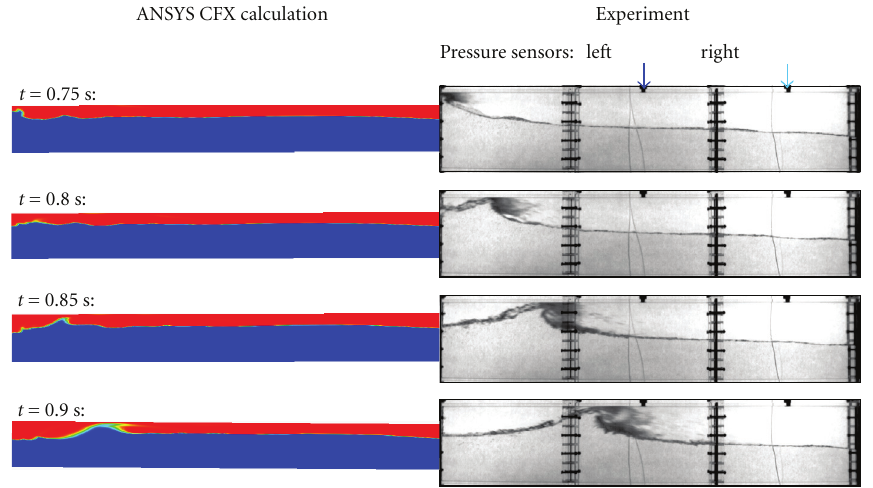
Figure 5: Comparative picture sequence of the recalculated slug.